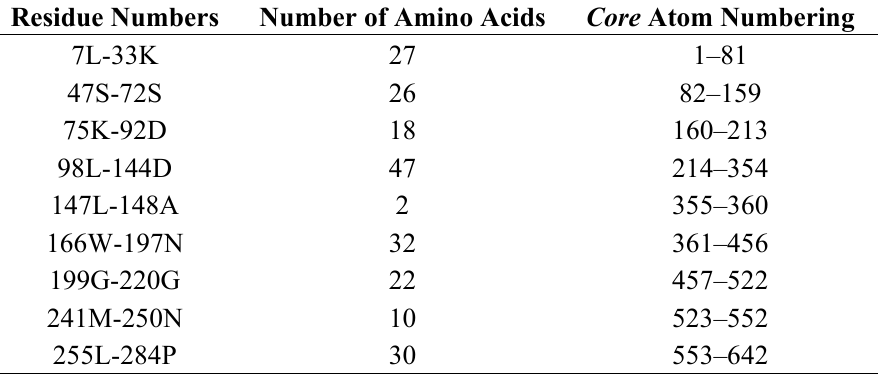
Table 1. Details of the 214 residues which made up the core as used for